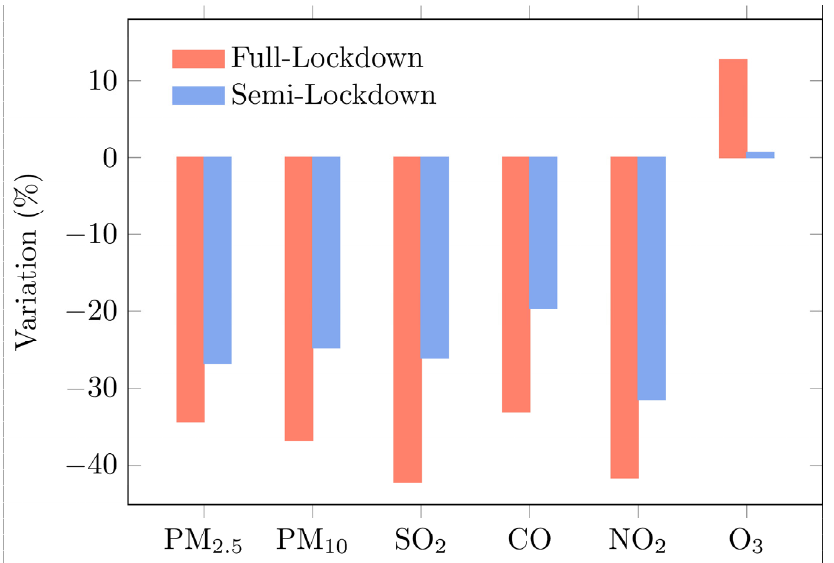
Figure 3. The variation of multiple airborne pollutants in semi-lockdown and full lockdown